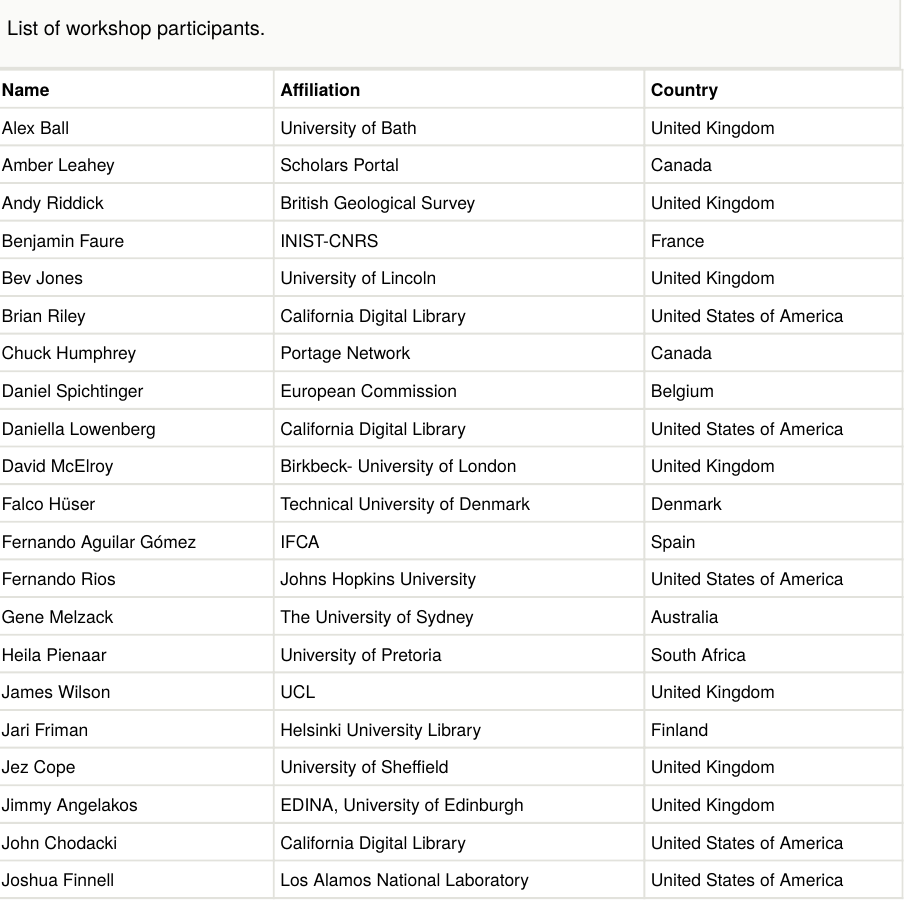
Table 1. List of workshop